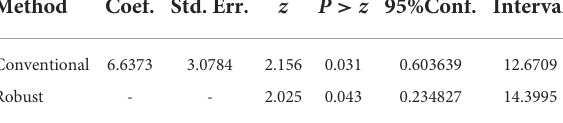
TABLE 8 RD analysis-polynomial